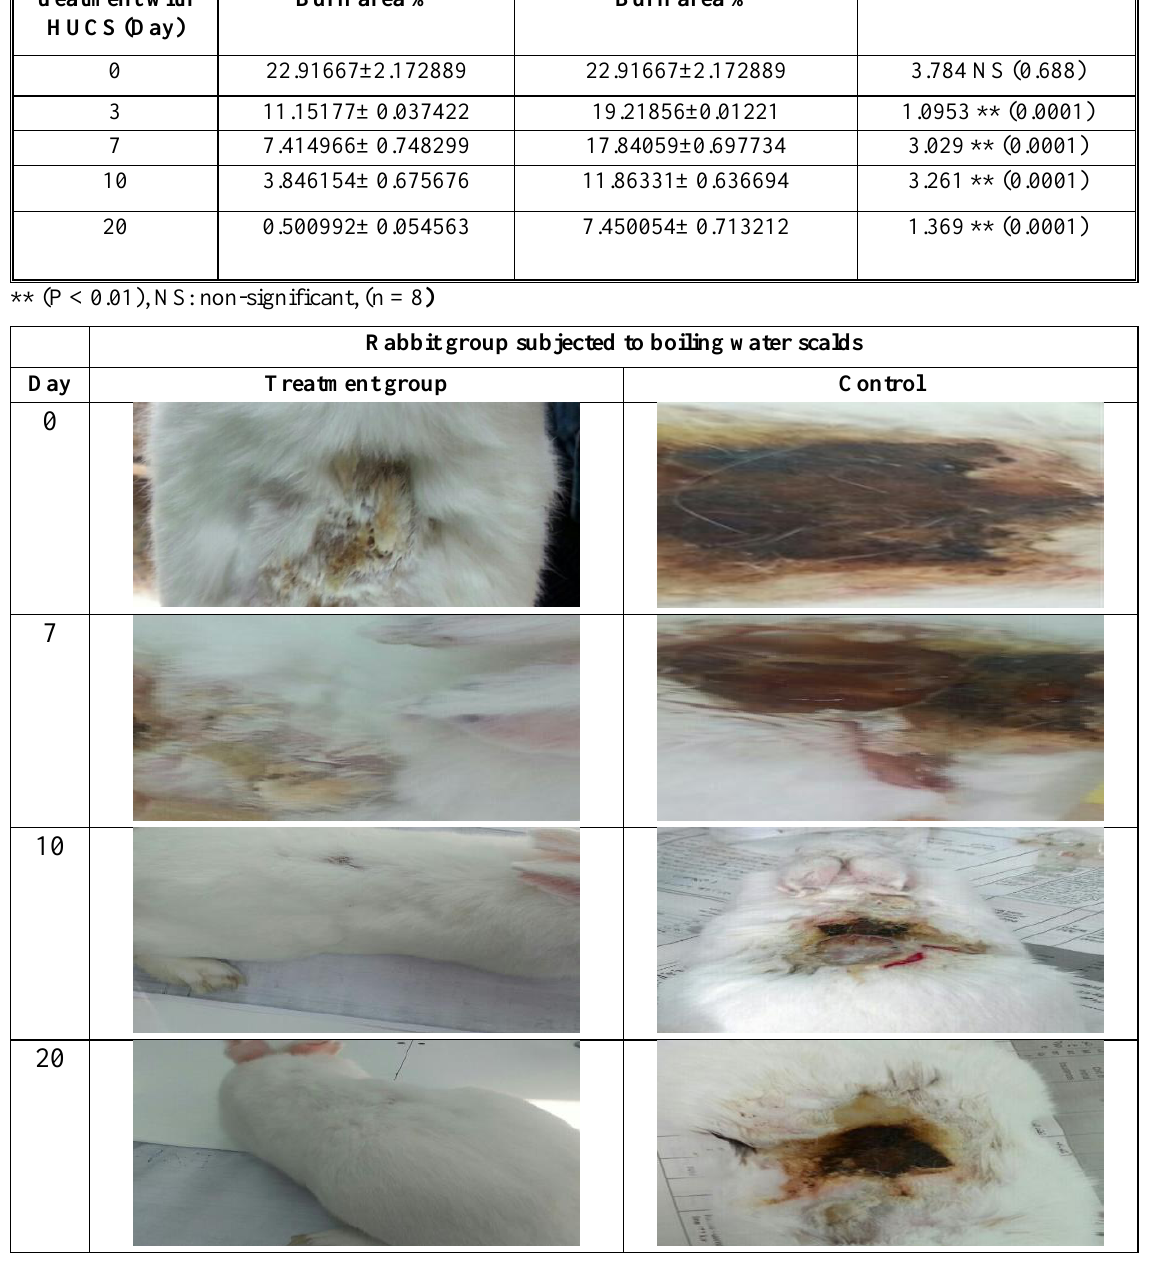
Figure 3. The difference in healing process between the scalded rabbit group treated with HUCS in comparison with control without